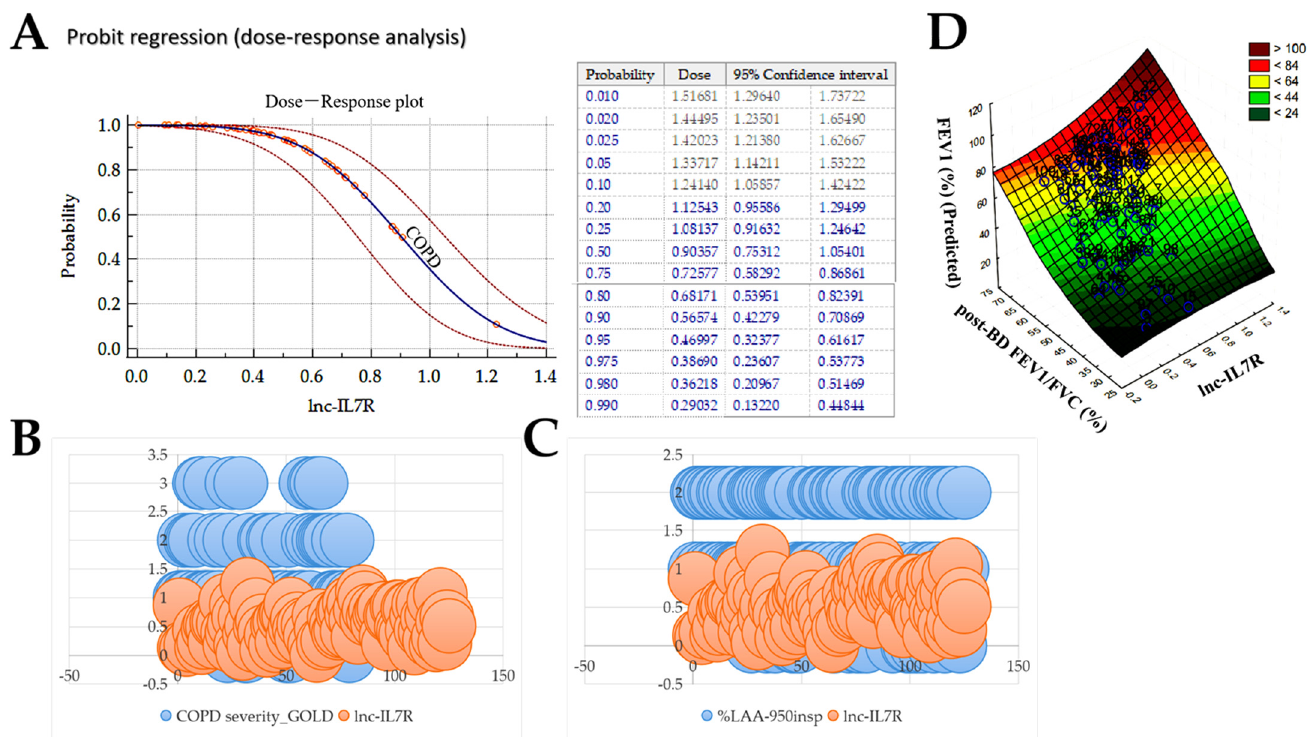
Figure 3. lnc-IL7R exhibits strong anti-COPD therapeutic potential. ( A ) Probit regression-based dose–response plot (left panel) and table (right panel) of the effect of lnc-IL7R expression on COPD probability. Bubble plots show how lnc-IL7R expression stratifies patients according to ( B ) GOLD- defined COPD severity, and ( C ) %LAA -950insp -based emphysema severity. ( D ) Surface plot of the correlation between lnc-IL7R expression, post-BD FEV 1 /FVC, and predicted FEV 1 .